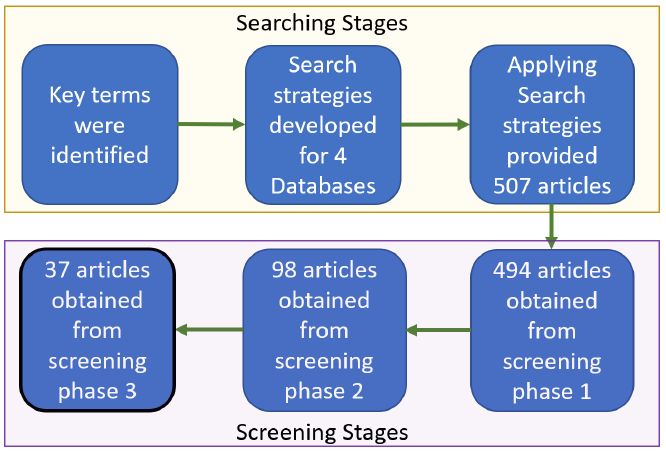
Figure 1. Six stage protocol implemented to obtain the articles for this literature